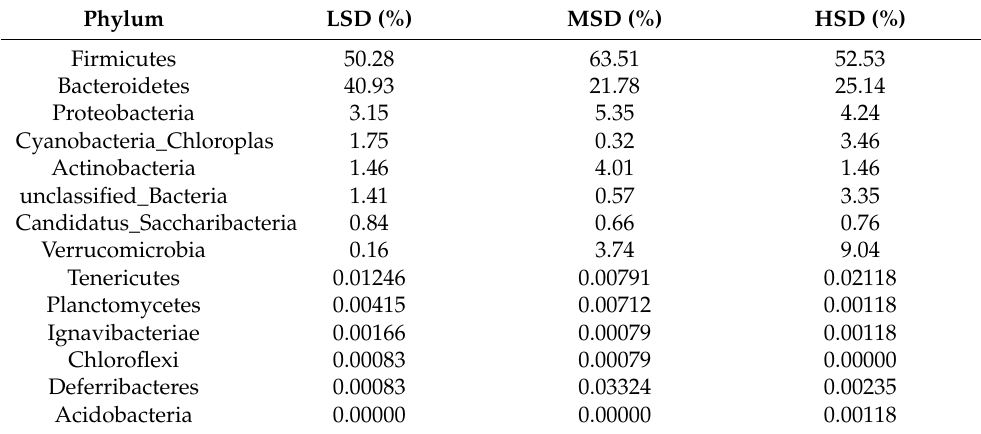
Table 3. The bacterial abundance of Kunming mice fed with LSD, MSD, and HSD for 12 weeks in phylum.